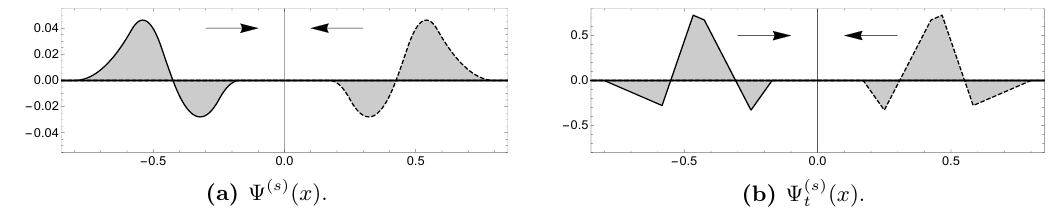
Figure 6 . Symmetric initial con(cid:12)guration of two compact exact oscillons parametrized by V = 0 : 8, v = 0 : 3, t 0 = 0 and x 0 = 0 : 8.